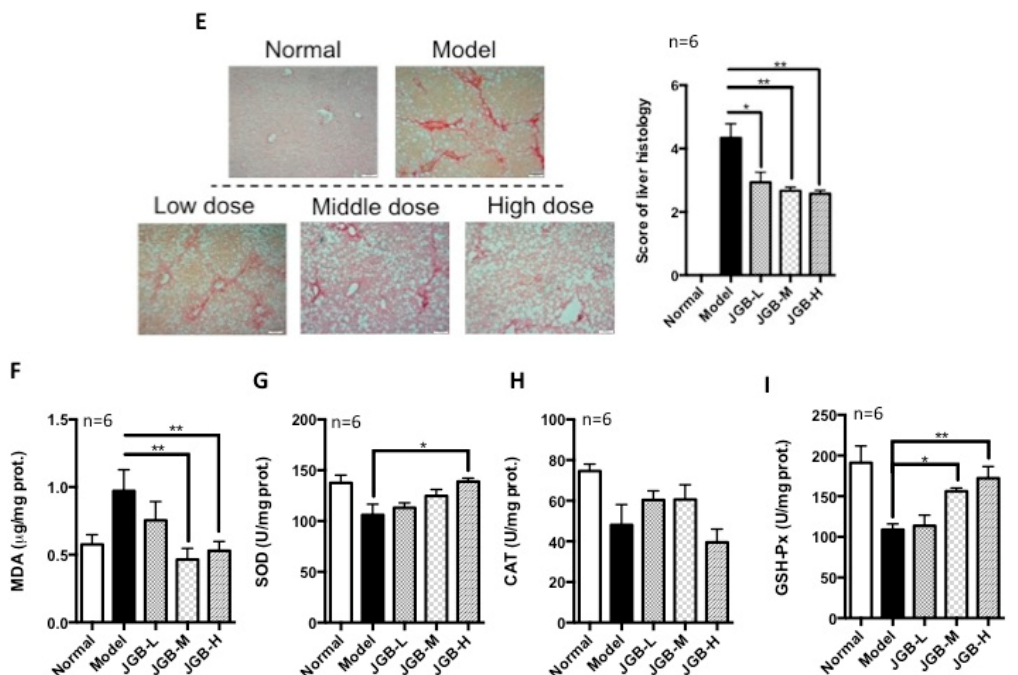
Figure 4. The effect of JGB on non-alcoholic fatty liver disease combined with CCl 4 fibrosis. ( A ) Serum ALT levels of mice from different groups; ( B ) Serum AST levels of mice from different groups; ( C ) H&E staining images and scoring of liver histology of mice from different groups; ( D ) Oil-red O staining images and scoring of liver histology of mice from different groups; ( E ) Picrosirius-red staining images and scoring of liver histology of mice from different groups; ( F ) MDA levels in liver of mice from different groups; ( G ) SOD levels of mice from different groups; ( H ) CAT levels of mice from different groups; ( I ) GSH-Px levels of mice from different groups. (JGB-L: JGB-low dose group, JGB-M: JGB-middle group, JGB-H: JGB-high group). Three biological replicates were performed for each study. * p < 0.05, ** p < 0.01, *** p < 0.001 when compared with model group.